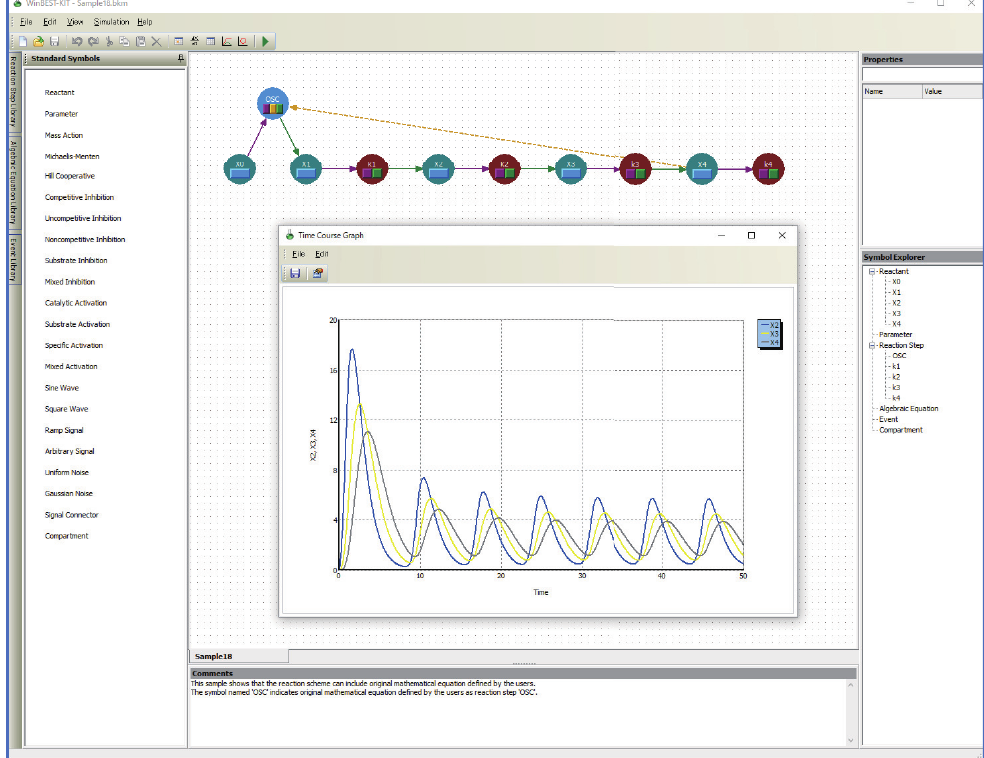
Figure 1. Screenshot of